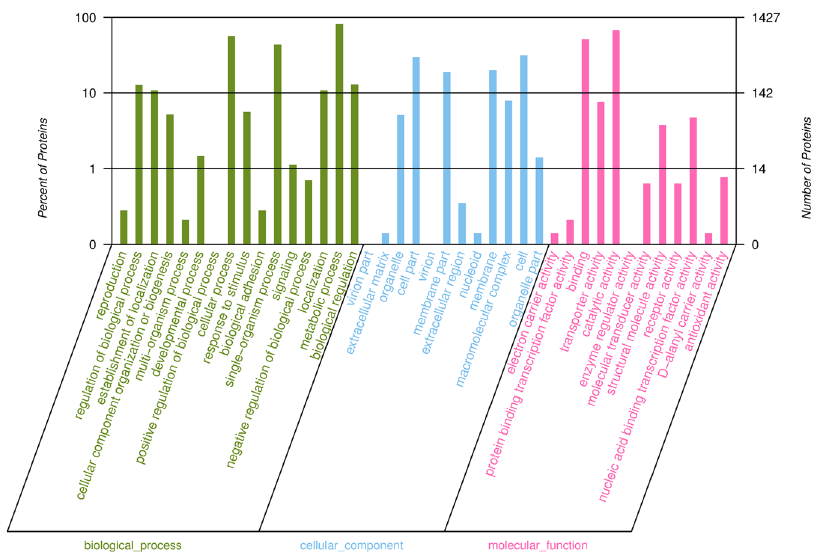
Figure 3. Functional categories of overlapped proteins identified in two L . plantarum strains by GO analysis. GO analysis was conducted by the software blast2go with the GO ID from the ensmbl database for each identified